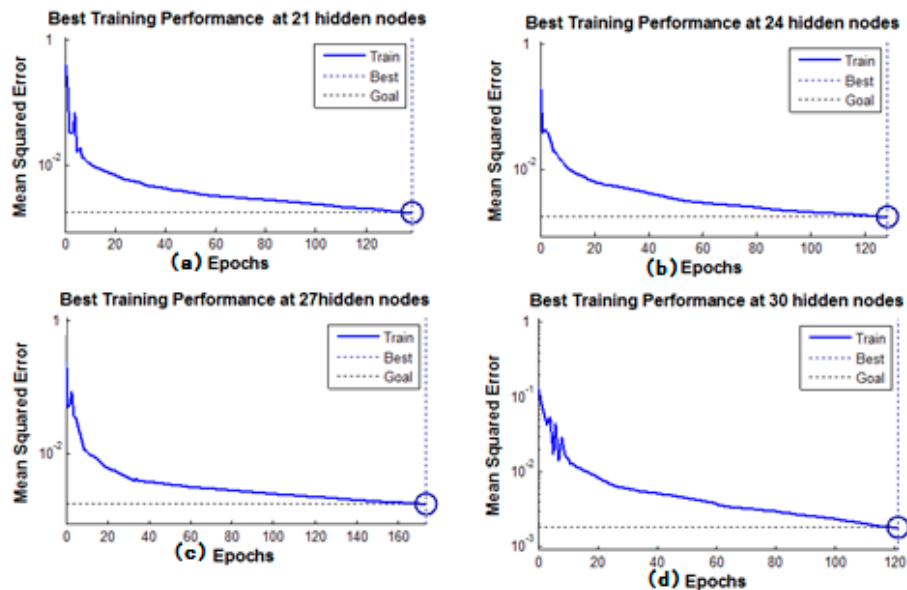
Figure 11. Training performance graphs for different hidden layer numbers: ( a ) 21 hidden nodes; ( b ) 24 hidden nodes; ( c ) 27 hidden nodes; and ( d ) 30 hidden nodes.